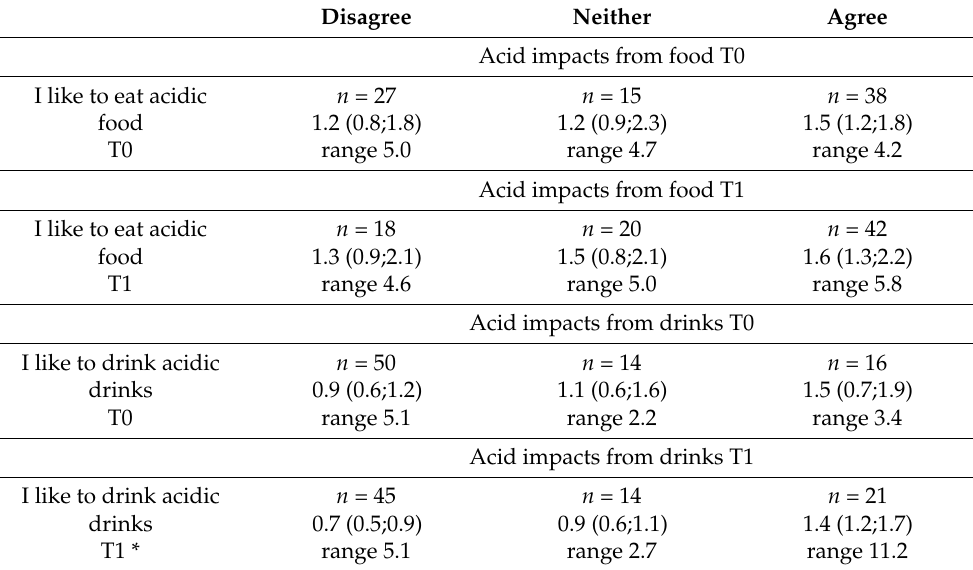
Table 2. The number of acid impacts per day (median, 95% confidence interval, and range) in the different categories of taste preferences at baseline (T0) and follow-up after one year (T1) (* = Kruskal–Wallis test p ≤ 0.001). Drinks include